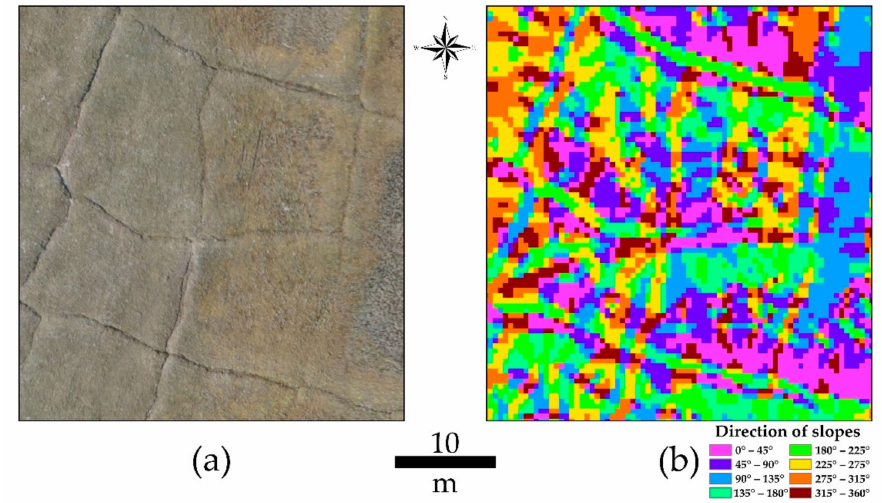
Figure 3. Incipient polygons (IP) in ( a ) an orthophoto map that is mixed with a grey shaded relief (GSR) map and ( b ) an aspect map, which shows flat centers of polygons without elevated rims.